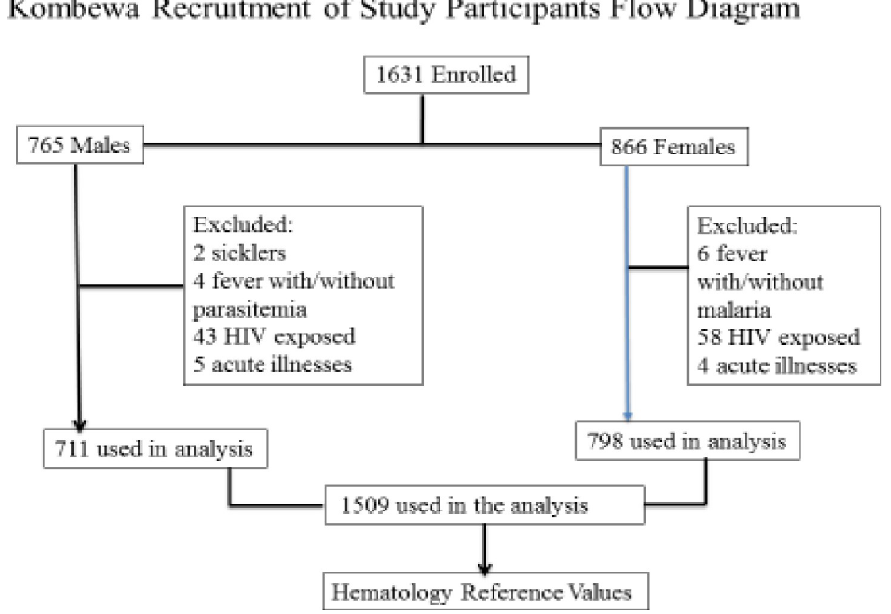
Fig 1. Flow diagram on recruitment of study